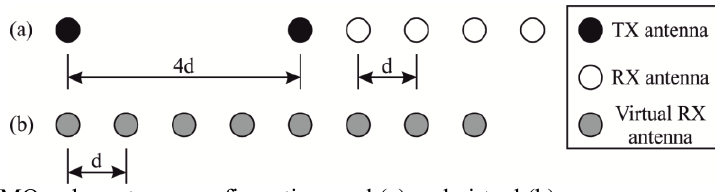
Fig. 4. MIMO radar antenna configuration: real (a) and virtual